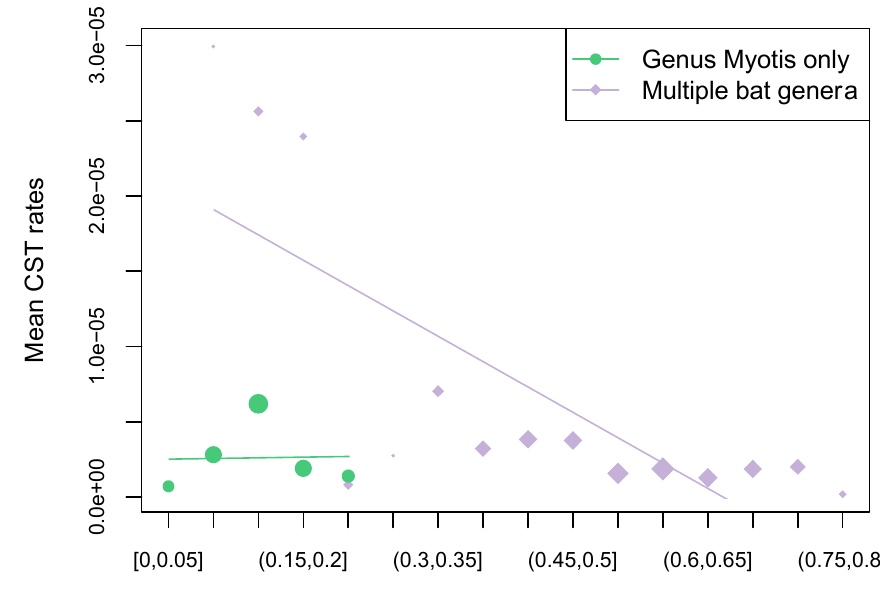
Figure 4. Frequency of inferred cross-species transmission events per year per capita among bat species as function of the genetic distances between species. Intervals of genetic distances values were delimited according to bin widths of 0.5 and means of mean number of expected CST events per year for each bin are shown. Point sizes are log-proportional to sample size (number of pairs of species) within each bin.